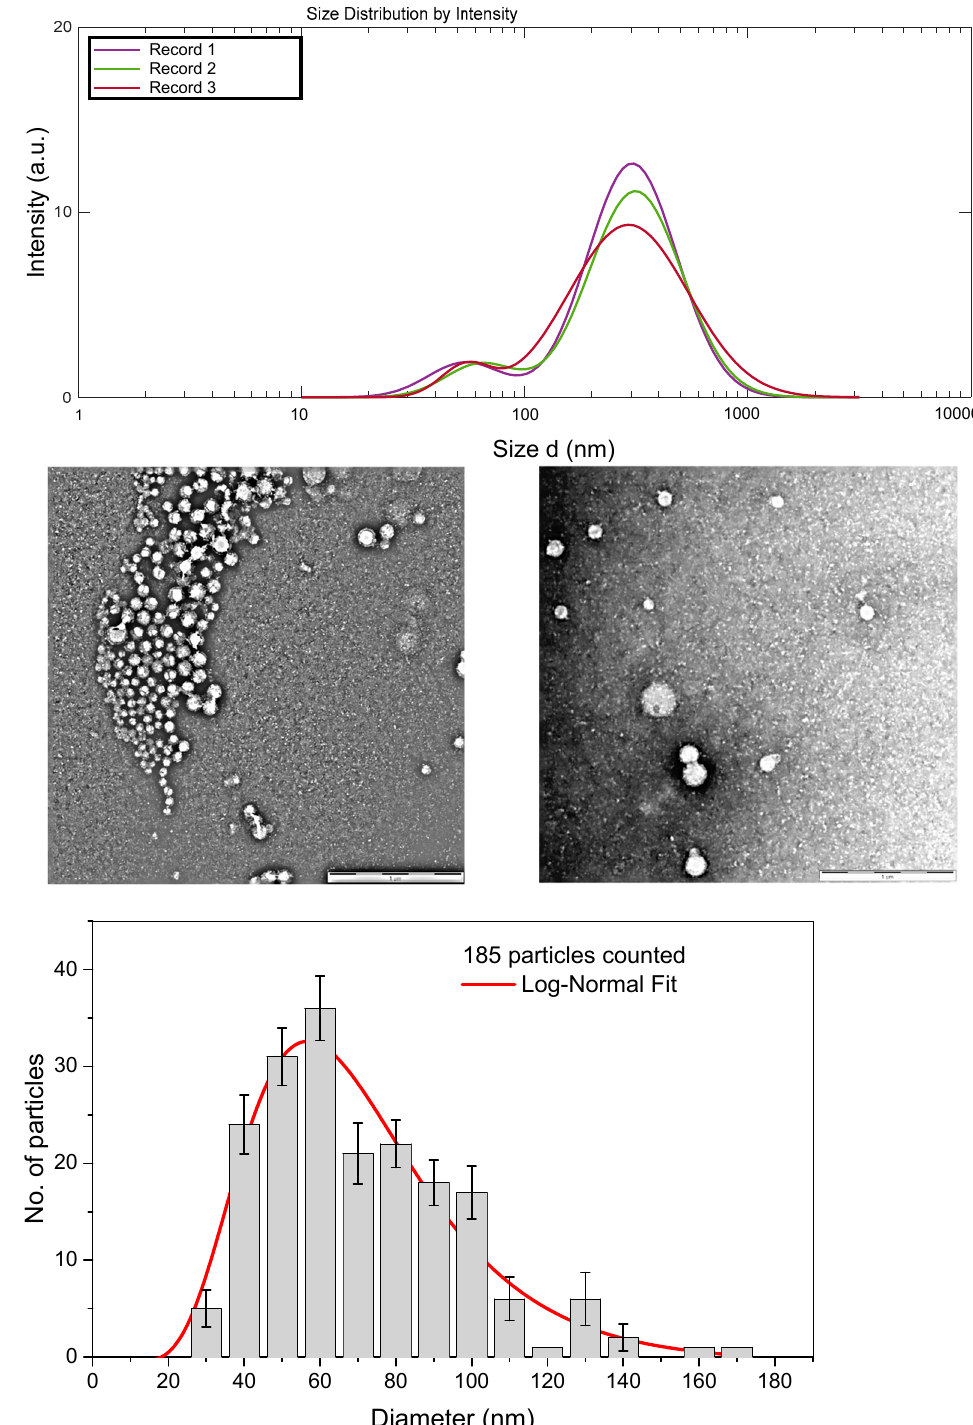
Figure 1. ( Top ) Hydrodynamic size distribution of the chitosan–caseinate nanoparticles, obtained by dynamic light scattering analysis. ( Middle ) TEM micrographs of chitosan–caseinate nanoparticles (scale bars: 1 µm). ( Bottom ) The corresponding number–average size distribution histogram of the obtained dried nanoparticles and adjusted log–normal distribution.